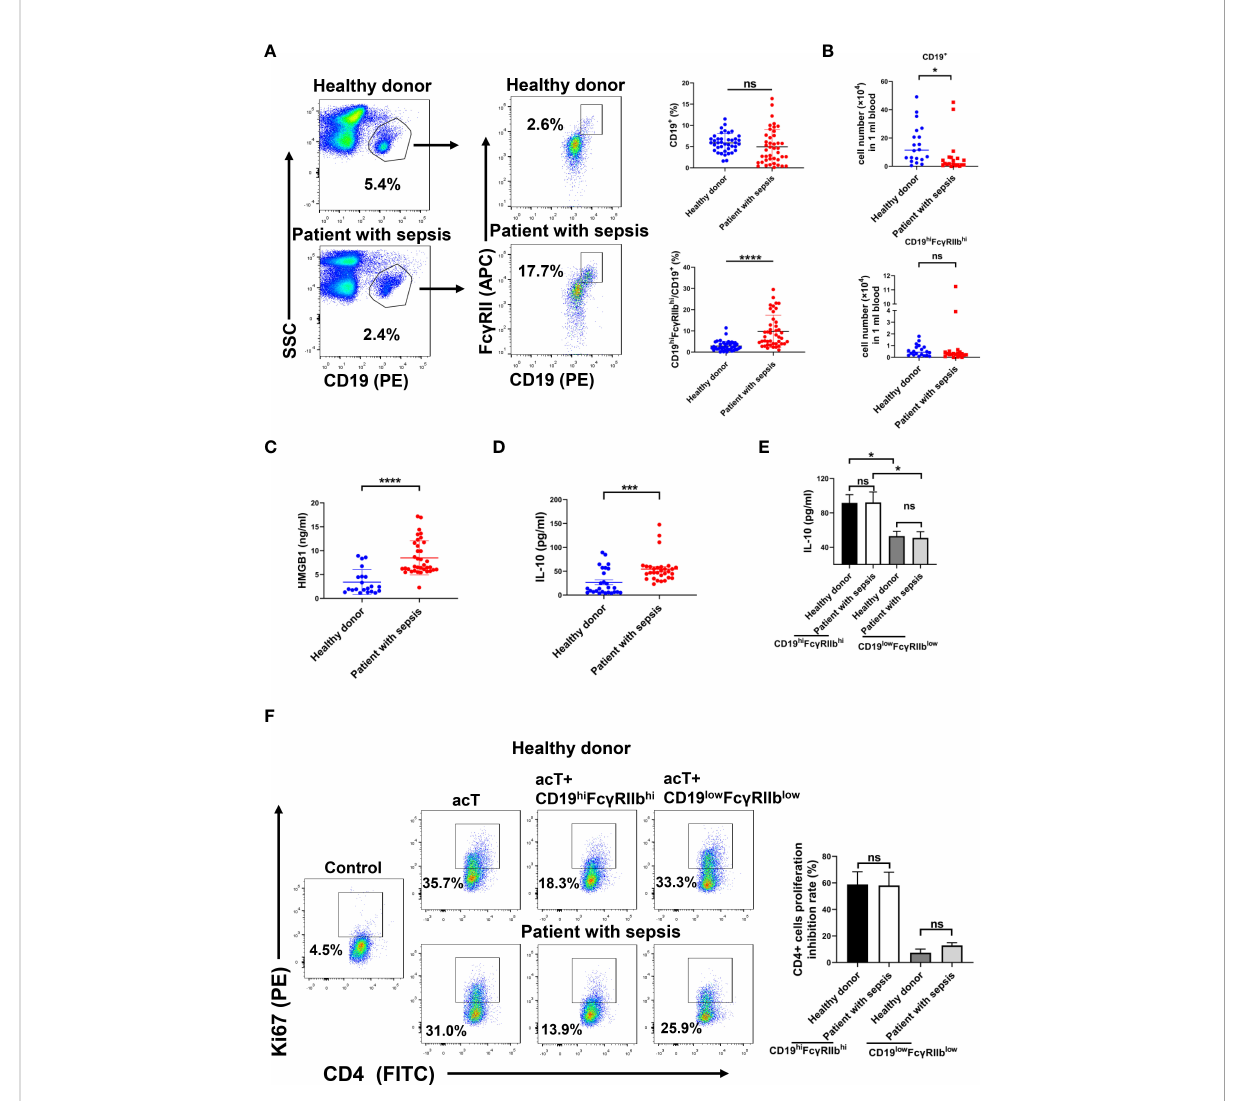
FIGURE 6 Increased percentage of CD19 hi Fc g RIIb hi B cells in peripheral blood from patients with sepsis. (A) Percentages of B cells and CD19 hi Fc g RIIb hi B cells among PBMCs of patients with sepsis and healthy donors were analyzed by fl ow cytometry. Data are shown as means ± SEMs; n = 40 samples for healthy donors, n = 44 samples for patients with sepsis. (B) Numbers of CD19 + B cells and CD19 hi Fc g RIIb hi B cells among PBMCs analyzed by fl ow cytometry. Data are shown as means ± SEMs; n = 20 samples per group. (C) HMGB1 levels in plasma analyzed by ELISA. Data are shown as means ± SEMs; n = 21 samples for healthy donors, n = 36 samples for patients with sepsis. (D) IL-10 levels in plasma analyzed by ELISA. Data are shown as means ± SEMs; n = 27 samples for healthy donors, n = 33 samples for patients with sepsis. (E) CD19 hi Fc g RIIb hi B cells and CD19 low Fc g RIIb low B cells were sorted from PBMCs of patients with sepsis and healthy donors by fl ow cytometry. CD19 hi Fc g RIIb hi B cells or CD19 low Fc g RIIb low B cells (2 × 10 5 ) were plated in 96-well plates. After 24 h, supernatants were collected for measurement of IL-10 levels by ELISA. Data are shown as means ± SEMs of three representative experiments; n = 3 samples per group. (F) CD19 hi Fc g RIIb hi B cells (1 × 10 5 /well) were cocultured with autologous anti-CD3/CD28 activated CD4 + T cells (1 × 10 5 /well) for 2 days, and Ki67 expression in CD4 + T cells was analyzed by fl ow cytometry. Results are representative of three independent experiments. Data are shown as means ± SEMs of three representative experiments; n = 3 samples per group. *P < 0.05; ***P < 0.001; ****P < 0.0001; NS, not signi fi